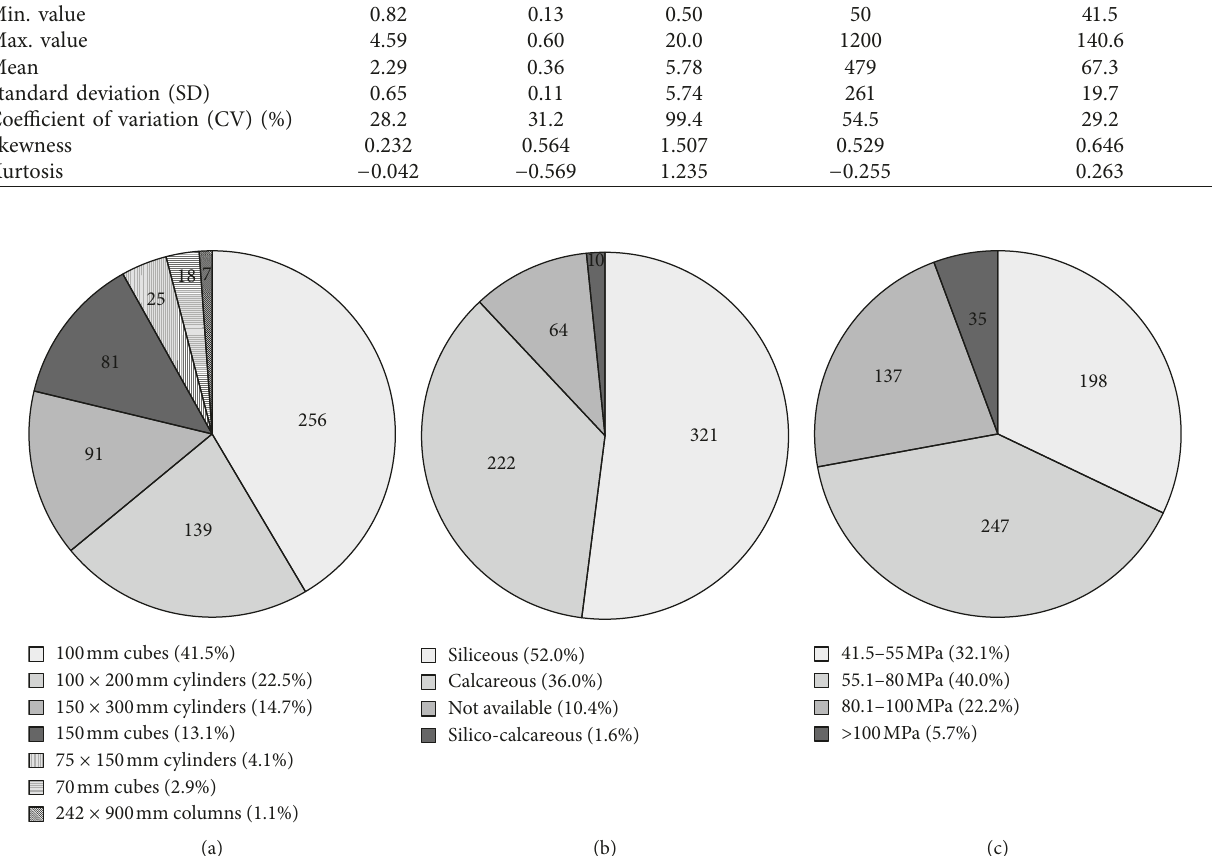
Figure 2: Distribution of all 617 HSC data points with respect to (a) type of the test specimen, (b) type of the coarse aggregate, and (c) compressive strength of concrete at room temperature ( f